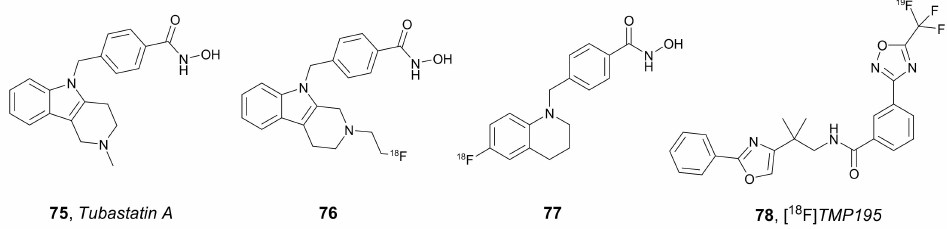
Figure 26. Chemical structures of compounds 75 – 78